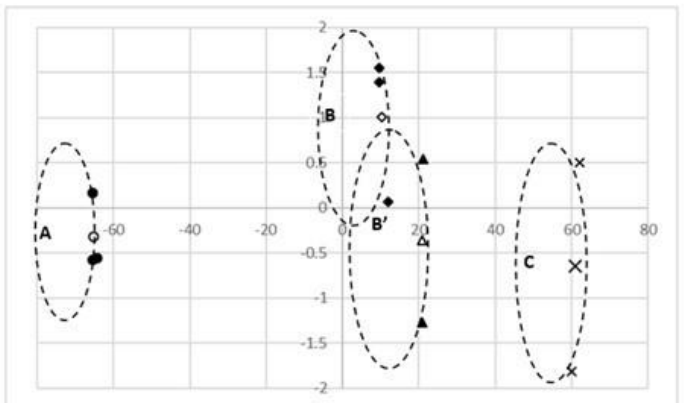
Figure 1. Canonical dispersions of uninfected Italian lemon ( A ), infected Italian lemon ( B ), uninfected Valencia orange ( B’ ), and infected Valencia orange ( C ). The ovals represent each of the aforementioned groups. Likewise, figures represent the values of the canonical dispersions, the white figures are the centroids and in the case of group C, the centroid is located in the larger X.